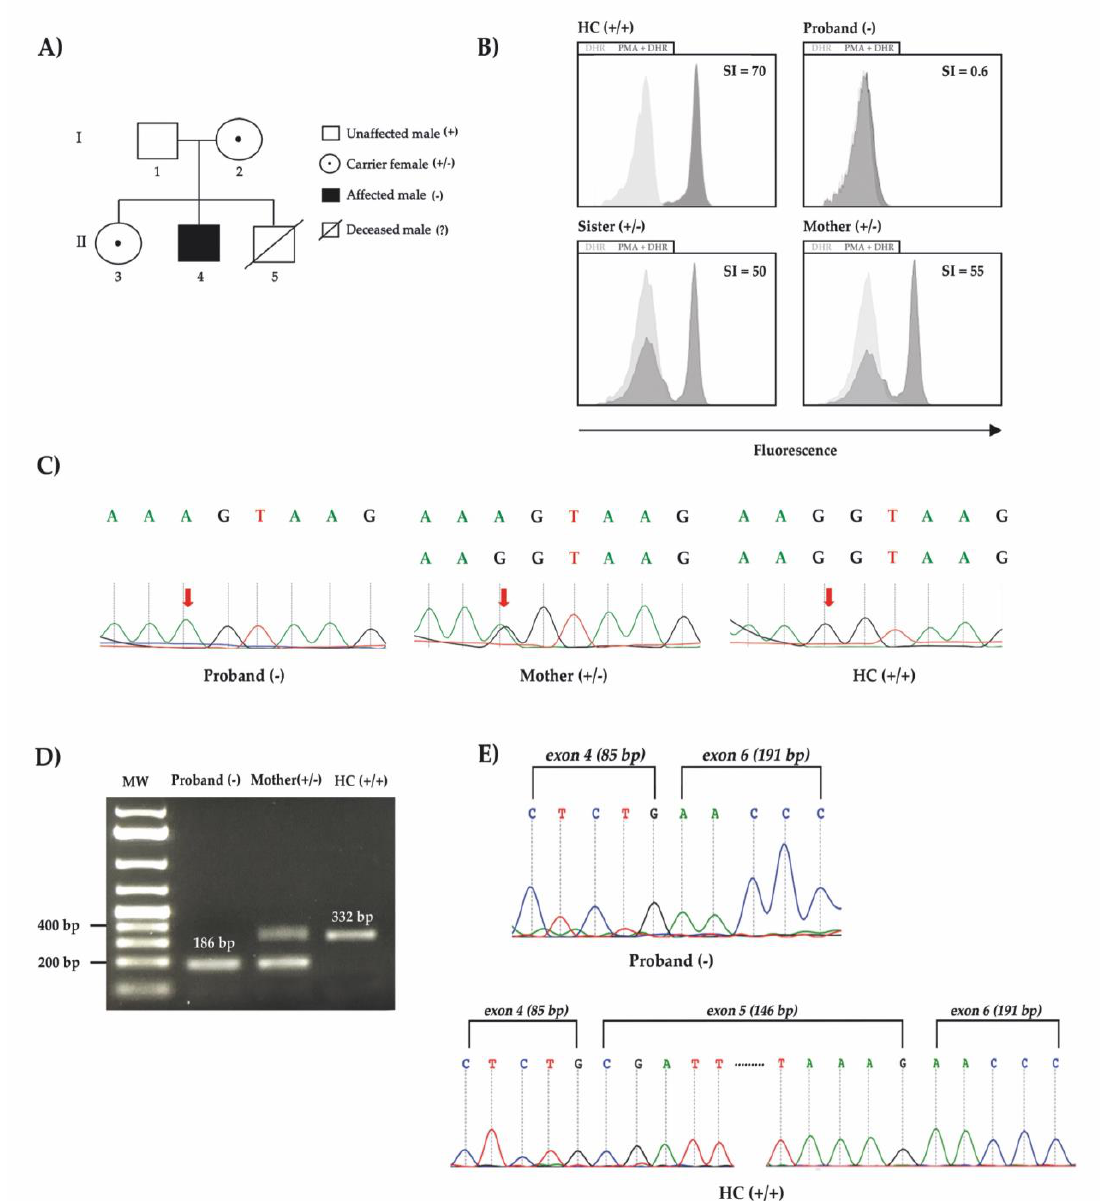
Figure 1. ( A ) The proband’s family pedigree of affected patients displaying two generations. White circles with central dots represent carriers, the proband is represented as a black square. ( B ) Flow cytometry was used to assess fluorescence intensity increase after neutrophils stimulation with PMA in presence of DHR123 (grey histogram) and control with DHR only (faint histogram). In the healthy control, the curve shifts to the right, showing a neutrophil’s response. The proband’s curves before and after stimulation overlap, showing that there was no phagocyte respiratory burst. The curves of the proband’s mother and sister partially shift, revealing their carrier state, seeing as, because of their heterozygous variant, part of their neutrophils responds but the rest does not. SI = stimulation index. ( C ) Electropherogram from DNA showing homozygous variant on the proband, heterozygous variant on the proband’s mother, a mutation carrier, and homozygous wild type allele in a healthy control. ( D ) cDNA PCR products confirming a small fragment from the proband compatible with exon 5 skipping in comparison to a healthy control (HC) on agarose gel. Healthy control (HC), proband’s mother and sister were positive, while the proband was negative, suggesting intronic retention. MW: molecular weight. ( E ) Electropherogram from cDNA showing exon 5 skipping on the proband and continuous exon 4 to 6 in a healthy control (HC).